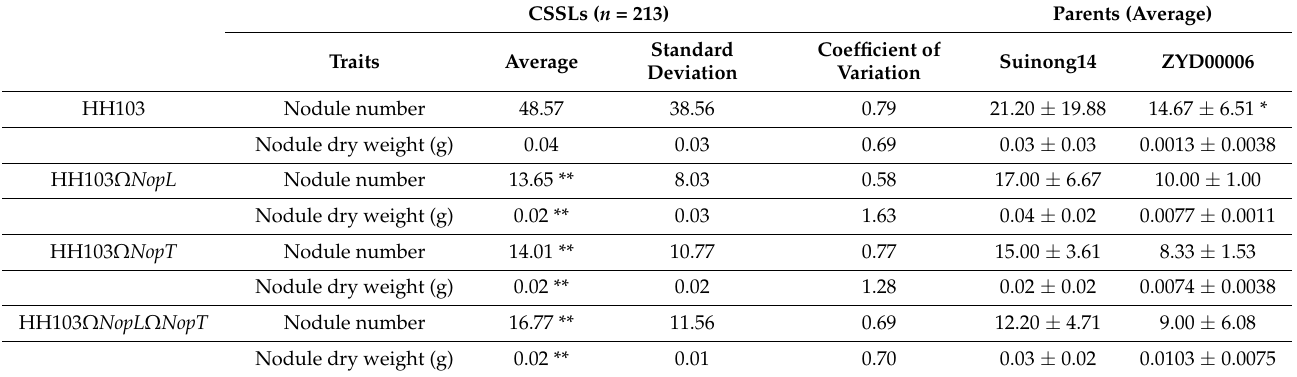
Table 1. Parental and population statistics for nodule traits in the soybean ‘Suinong14 (cid:48) × ‘ZYD00006 (cid:48)